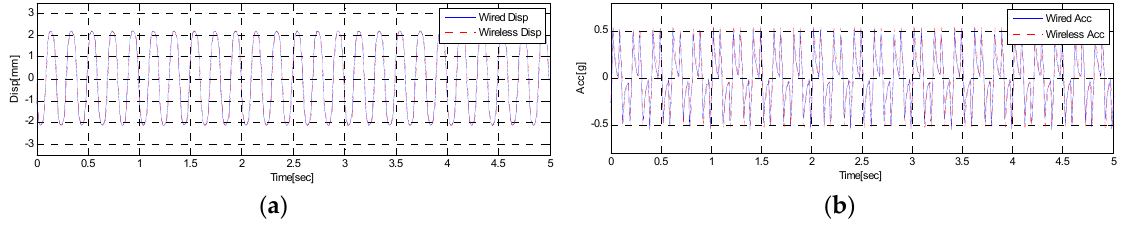
Figure 7. Wired and wireless response using a modal shaker: ( a ) Comparison of displacement; ( b ) comparison of acceleration.